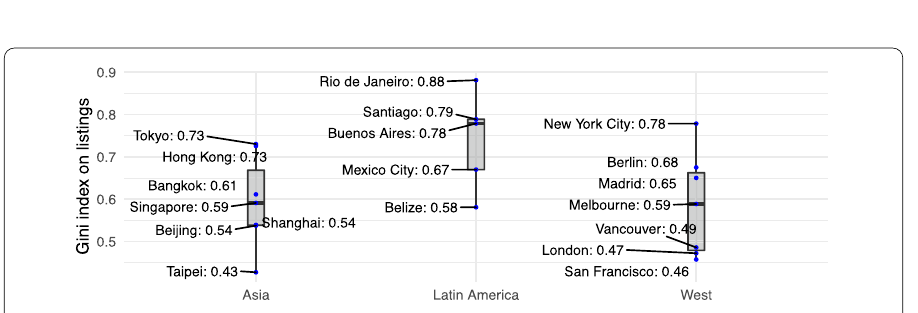
Figure 3 Host inequality measured as Gini coefficient of the number of listings per area